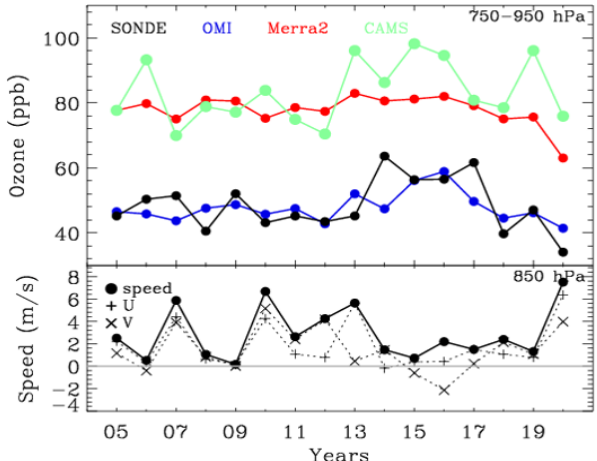
Figure 6. Annual variations of (top) the lower-tropospheric ozone (750–950hPa) in August from various ozone products, along with (bottom) the wind speeds at